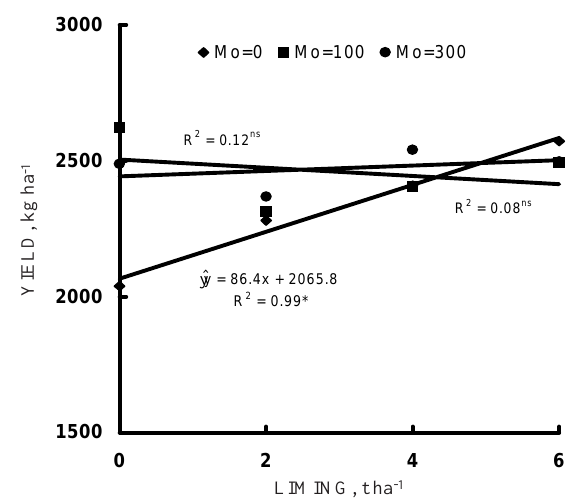
Figure 1. Lime and molybdenum interaction on peanut yield in low pH soil. Results of treatments with no lime application (averaged of three successive harvests). * and ns significant at 0.05 probability and non significant respectively.